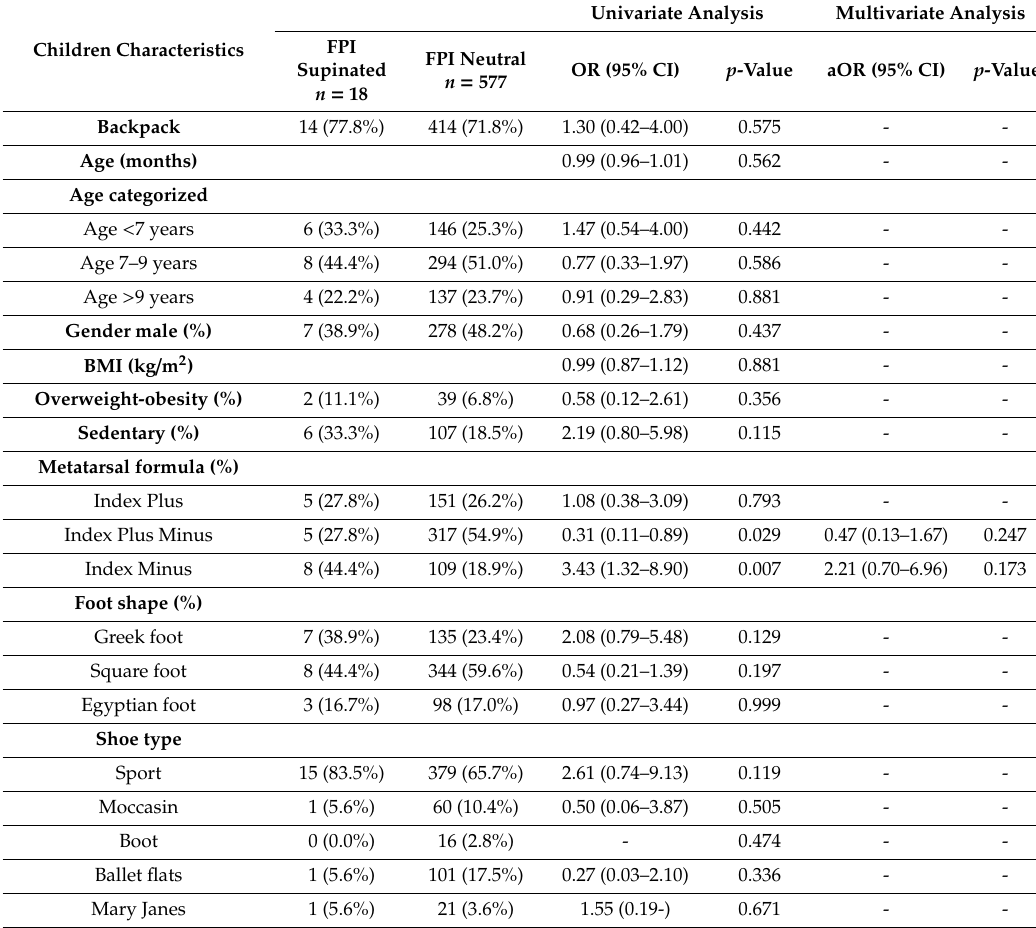
Table 4. Predictors of the changes from neutral foot to supinated